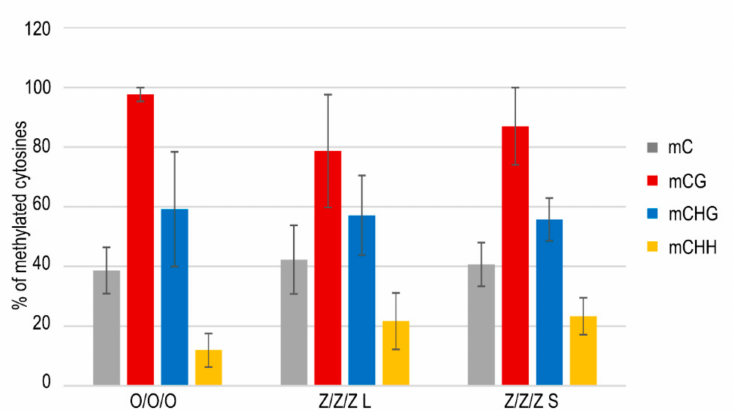
Figure 4. SPM11 transposon methylation analyzed by bisulfite sequencing. Methylation of 44 cytosines located in an amplified 336 bp region (6 cytosines in the CG sequence context, 14 cytosines in the CHG, 24 cytosines in the CHH, H = A, T, C) was evaluated by the CyMATE software [27]. Five to ten clones were analyzed per sample; mean values of methylated cytosines and standard deviations are presented. O/O/O, leaf of the control Col plant; Z/Z/Z L, leaf of 3G plant with long telomeres grown from seedlings exposed to zebularine during germinations; Z/Z/Z S, leaf of 3G plant with short telomeres grown from seedlings exposed to zebularine during germinations (see Figure 2a). For experimental design and nomenclature of samples, see Figure